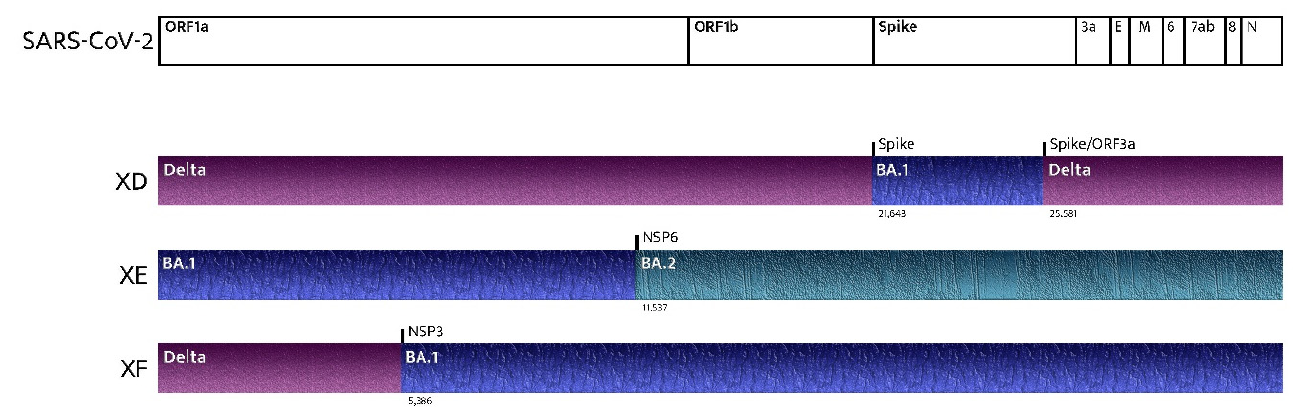
Figure 2. Recombinant SARS-CoV-2 variants: where do they come from? On 14 April, the WHO Africa announced that research in Botswana and South Africa had detected new sub-lineages of the Omicron variant, namely BA.4 and the BA.5, that